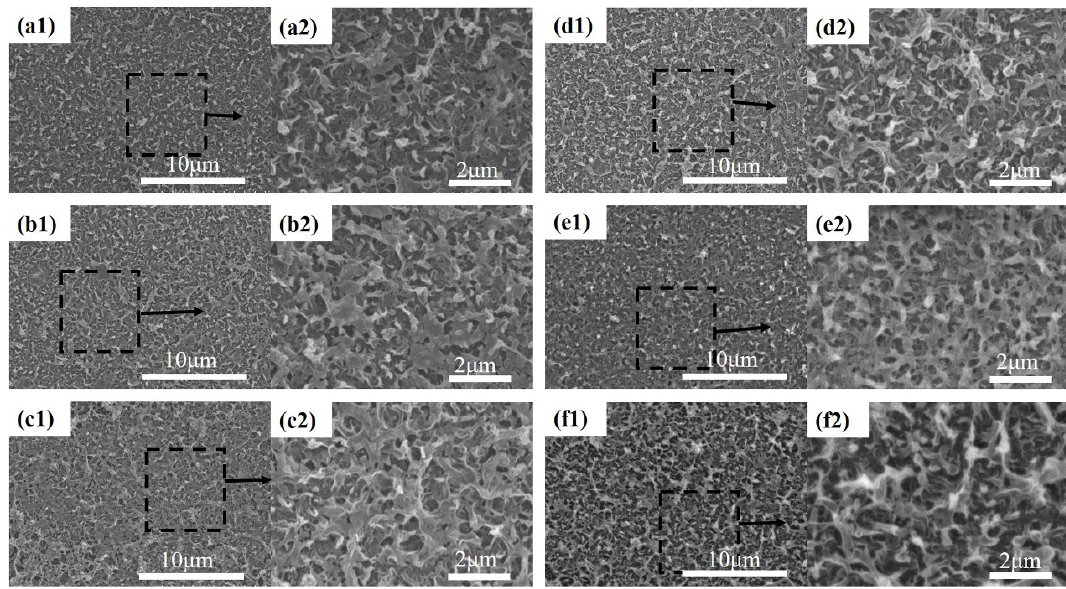
Figure 5. Surface SEM images of the polyamide TFC membranes with different supports: ( a1 , a2 ) TFC−0, ( b1 , b2 ) TFC−1, ( c1 , c2 ) TFC−2, ( d1 , d2 ) TFC-3, ( e1 , e2 ) TFC−4, ( f1 , f2 ) TFC-5.